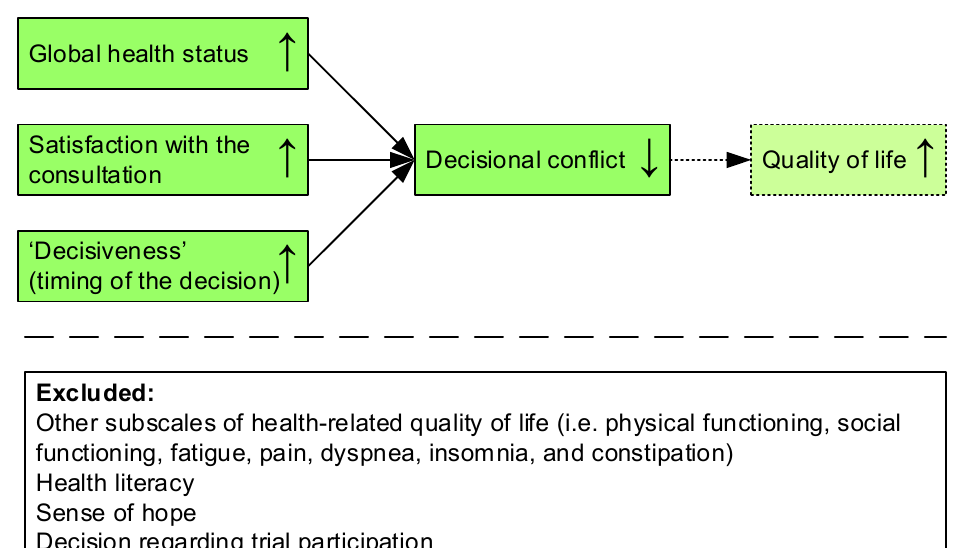
Figure 2. Model of predictors for decisional conflict.